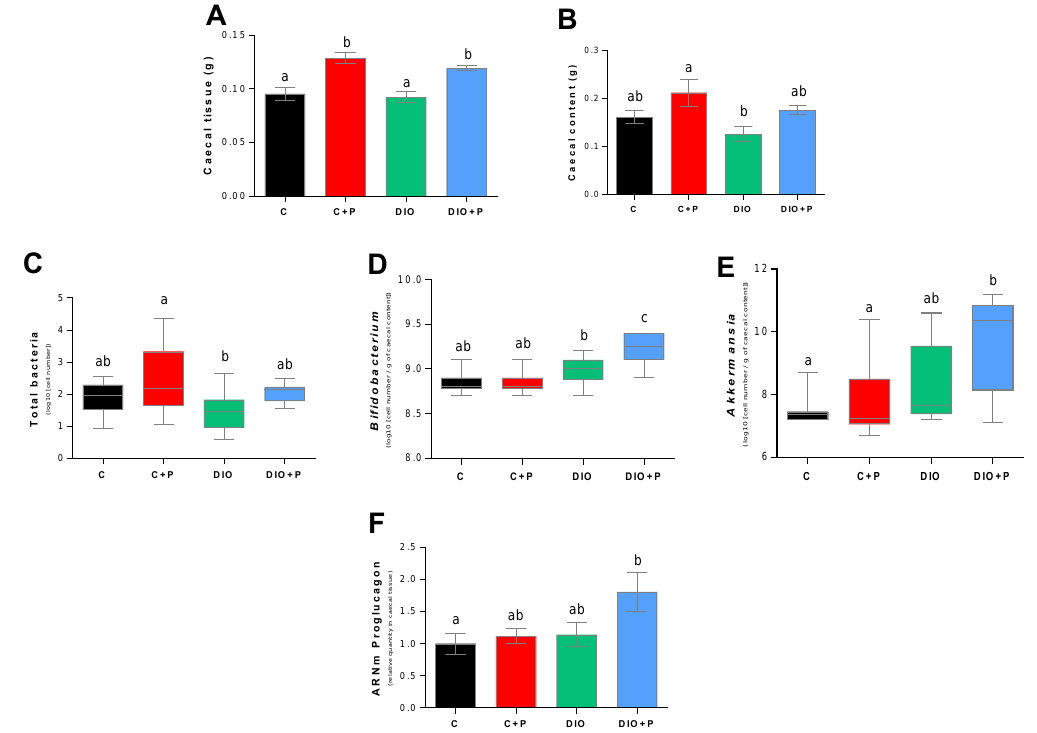
Figure 2. Comparison of bacterial parameters in mice subjected for 12 weeks to a regulatory chow or an obesogenic diet alone (C and DIO) or supplemented with 10% Prebiotic (C+P and DIO+P). ( A ) Cecal tissue mass; ( B ) Fecal mass in caecum; ( C ) total cecal bacteria; ( D ) Bifidobacterium ; ( E ) Akkermansia muciniphilla ; ( F ) relative proglucagon mRNA levels in caecum in reference to a housekeeper gene (RPL19). Mean ± SEM, different letters indicate a statistical difference between groups. Significance was achieved at p < 0.05. C, C+P, DIO, n = 10. DIO+P, n =